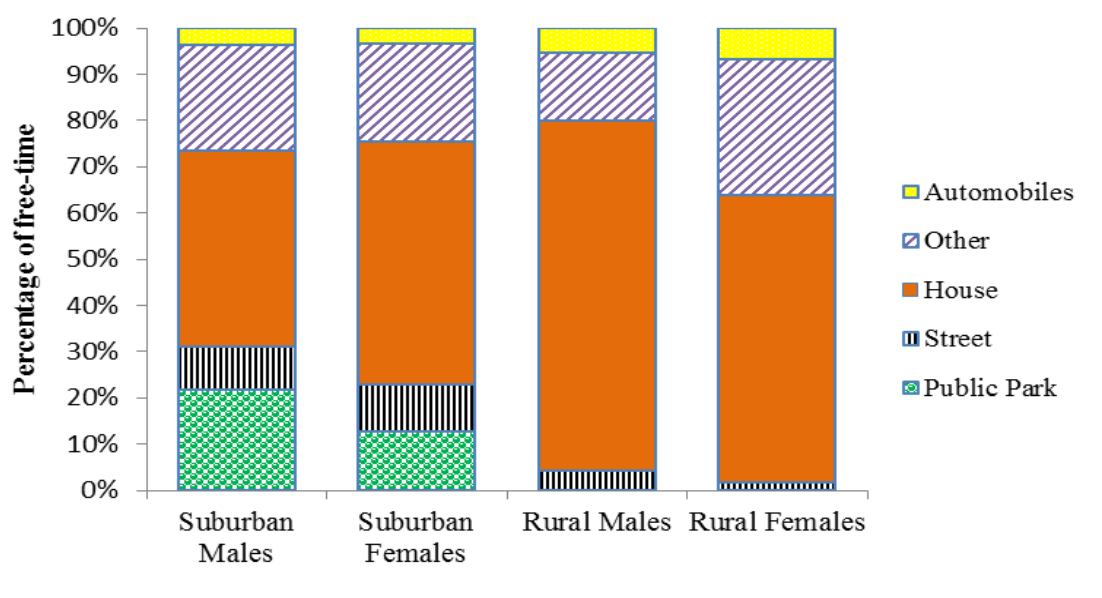
Figure 3. Percentage of free-time that suburban and rural youth spend in different environments on average during